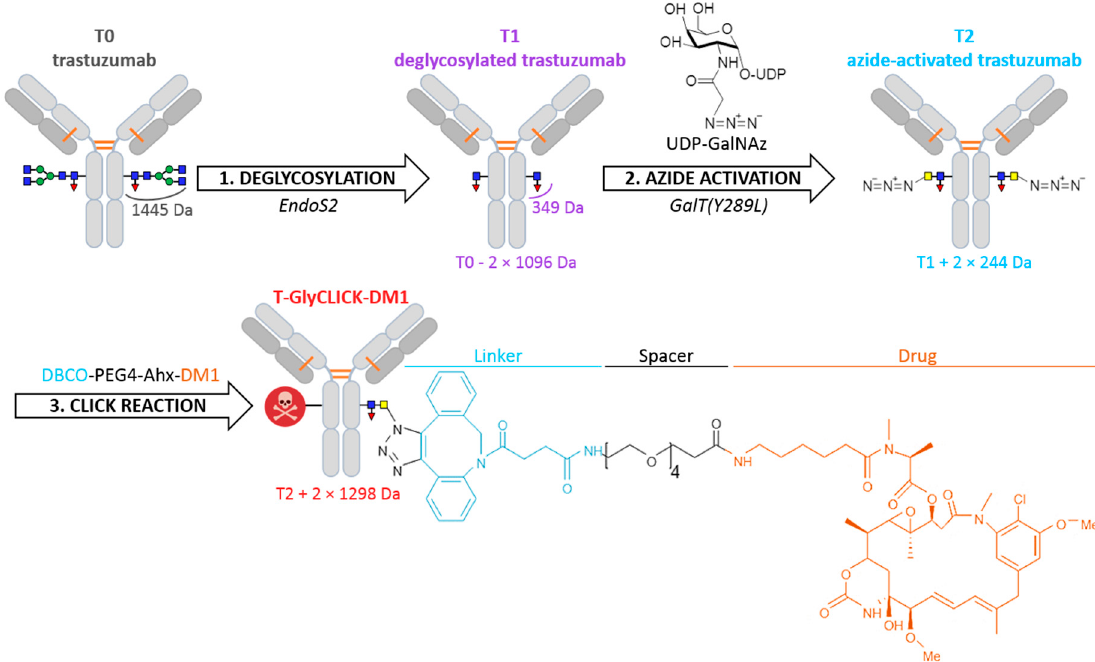
Figure 1. Schematic overview of the bioconjugation protocol. N-glycans remodeling of trastuzumab (T0) through deglycosylation, azide activation and click-chemistry, generating deglycosylated trastuzumab (T1), azide-activated trastuzumab (T2) and T-GlyCLICK-DM1, respectively.